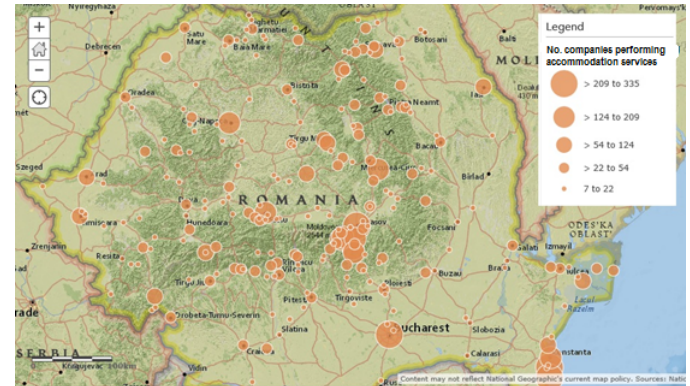
Figure 1: Spatial distribution of accommodation